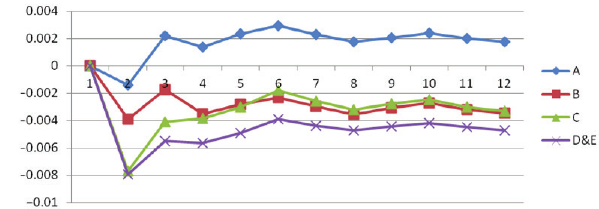
Figure 9h. Accumulated impulse response of PRI to shocks in housing supply